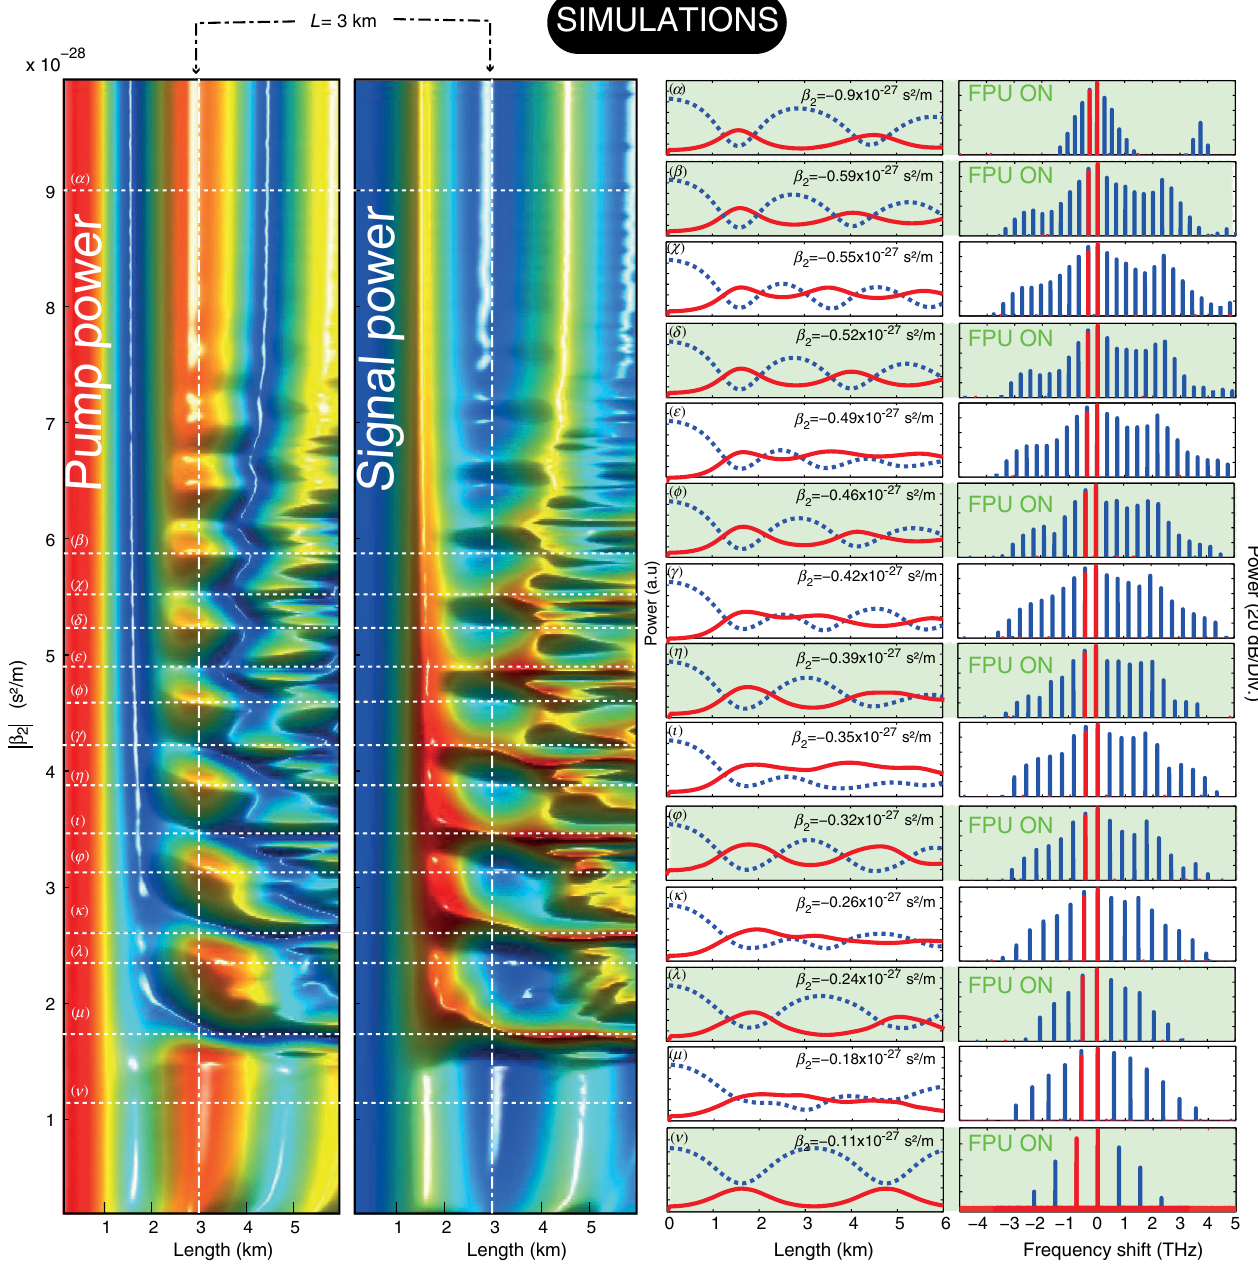
FIG. 5 Numerical data. Left two columns: False color plots of the pump and signal powers versus fiber length and dispersion. The third column: Evolution of the signal power (solid red lines) and of the pump power (dotted blue lines) versus fiber length for specific values of dispersion. Right column: Corresponding spectra at L ¼ 3000 m (blue bars) and L ¼ 0 (red bars). Light pink panels in the two right columns show the cases where FPU recurrence is on, while the white panels show the cases where FPU recurrence is